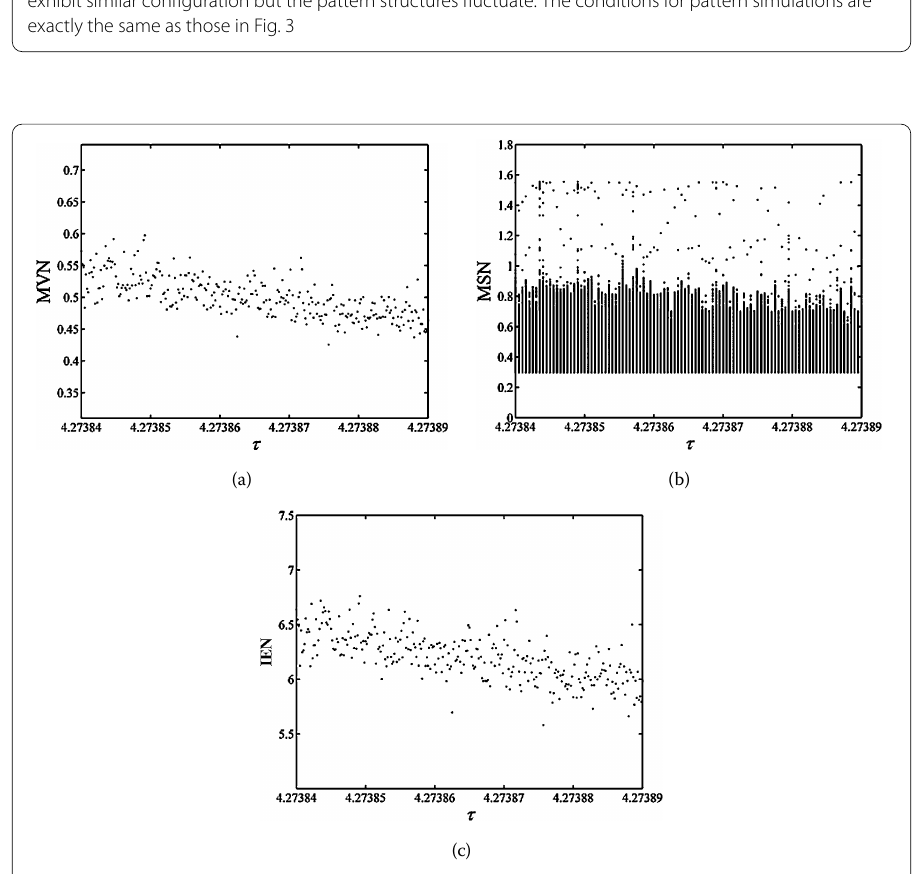
Figure 11 Graphs of ( a ) MVN, ( b ) MSN, and ( c ) IEN corresponding to Fig. 10, demonstrating stochastic pattern fluctuation in the pattern transition